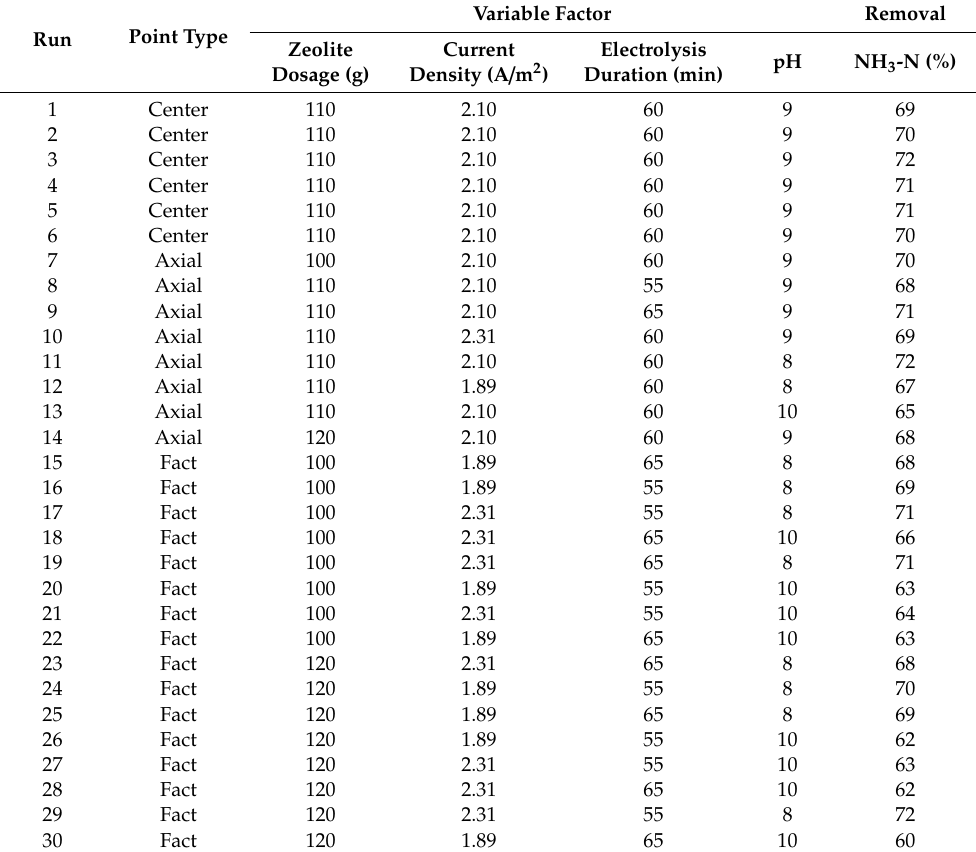
Table 5. Design matrix and experimental results for optimized variables of